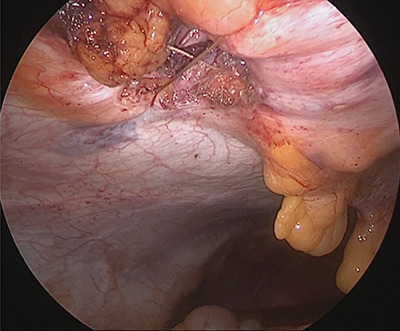
Completed Z suture.